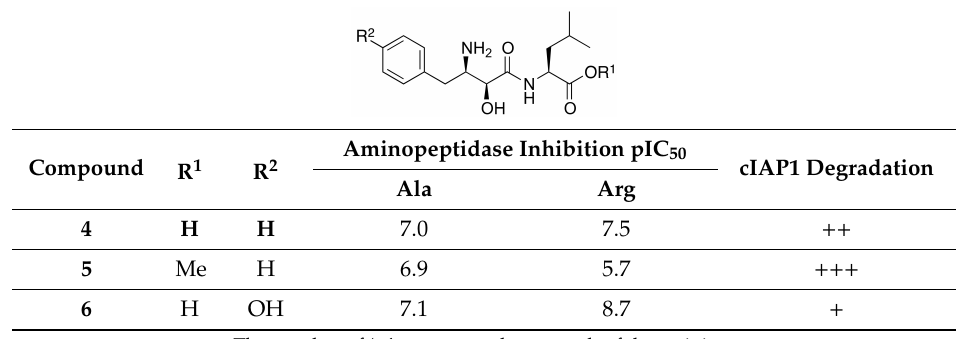
Table 2. Biological activities of bestatin analogs